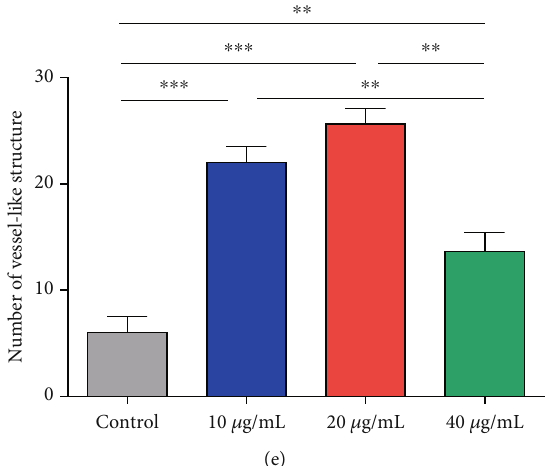
Figure 3: ADSC-EVs promoted the migration and tube formation activities of HUVECs. Scratch assay (a) and tube formation assay (b) of HUVECs after treatments with PBS, 10 μ g/mL, 20 μ g/mL, and 40 μ g/mL ADSC-EVs. Representative images of each group are shown. Scar bar = 250 μ m . The width change (c), tube length (d), and number of vessel-like structure (e) of each group are shown. n = 6 , 3, and 3 for width change, tube length, and vessel-like structure, respectively. ∗ P < 0 : 05, ∗∗ P < 0 : 01, and ∗∗∗ P < 0 : 001